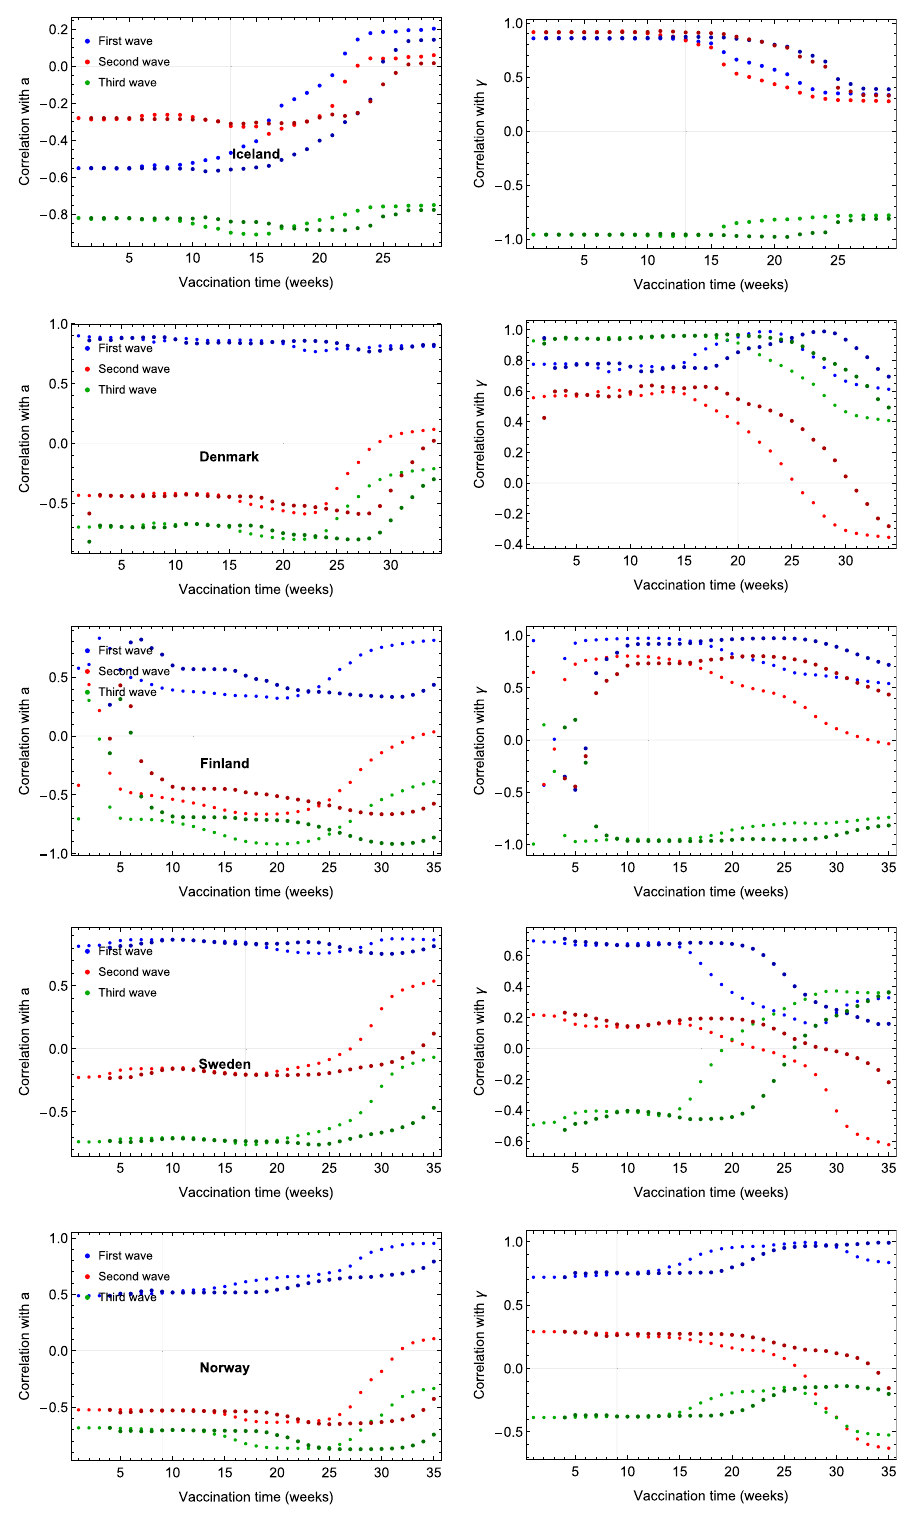
Figure 12. Correlation between the last wave fit parameters and vaccination percentage for Iceland, Denmark, Finland, Sweden and Norway. The vertical grey line indicates the peak timing of the last wave in the